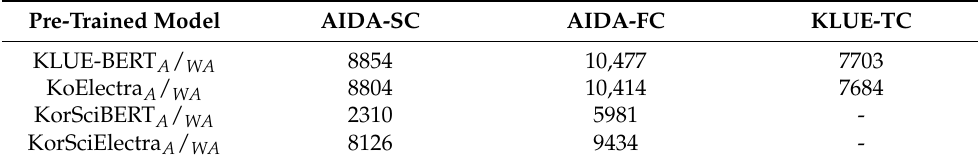
Table 2. The number of extended vocabularies. Extended vocabularies added to the A and WA models are the same. A is a model with extension vocabulary. WA is a model with extension vocabulary and curriculum